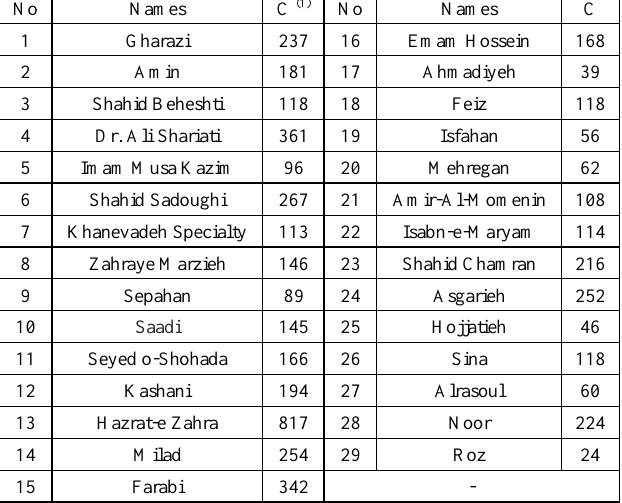
Table 3. List of hospitals and their capacities by the number of beds in Isfahan.